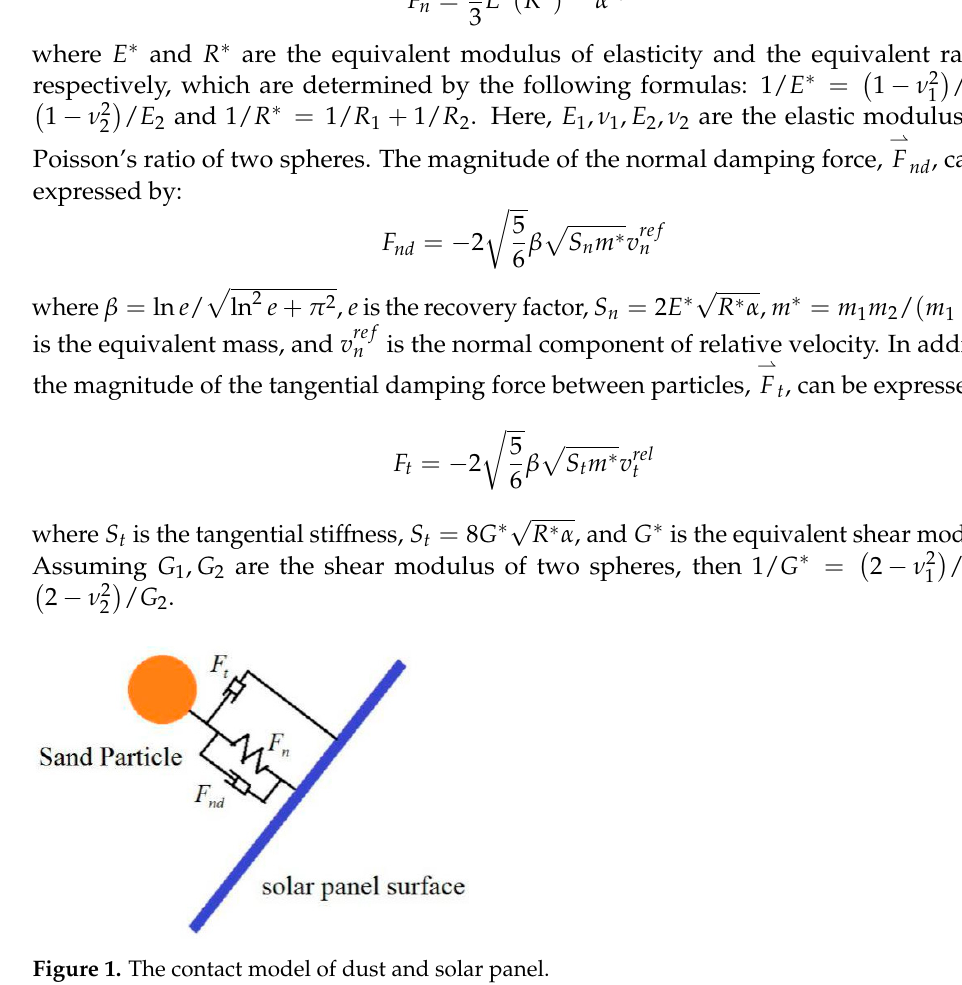
Figure 1. The contact model of dust and solar panel.